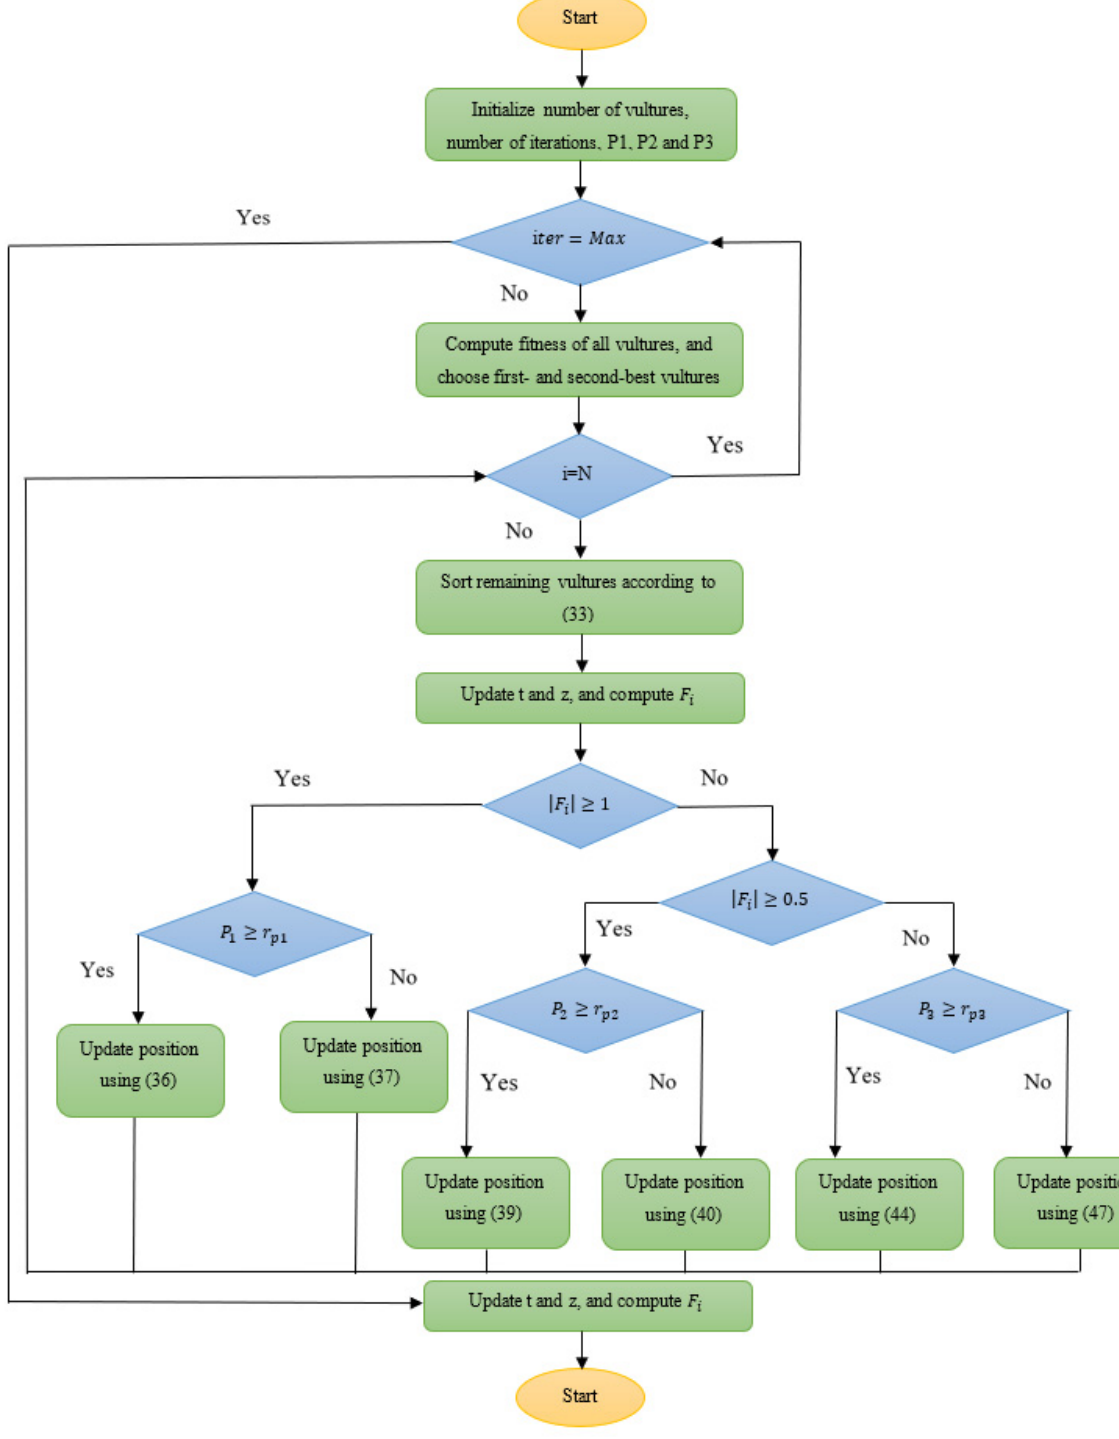
Figure 8. Method of execution of AVOA